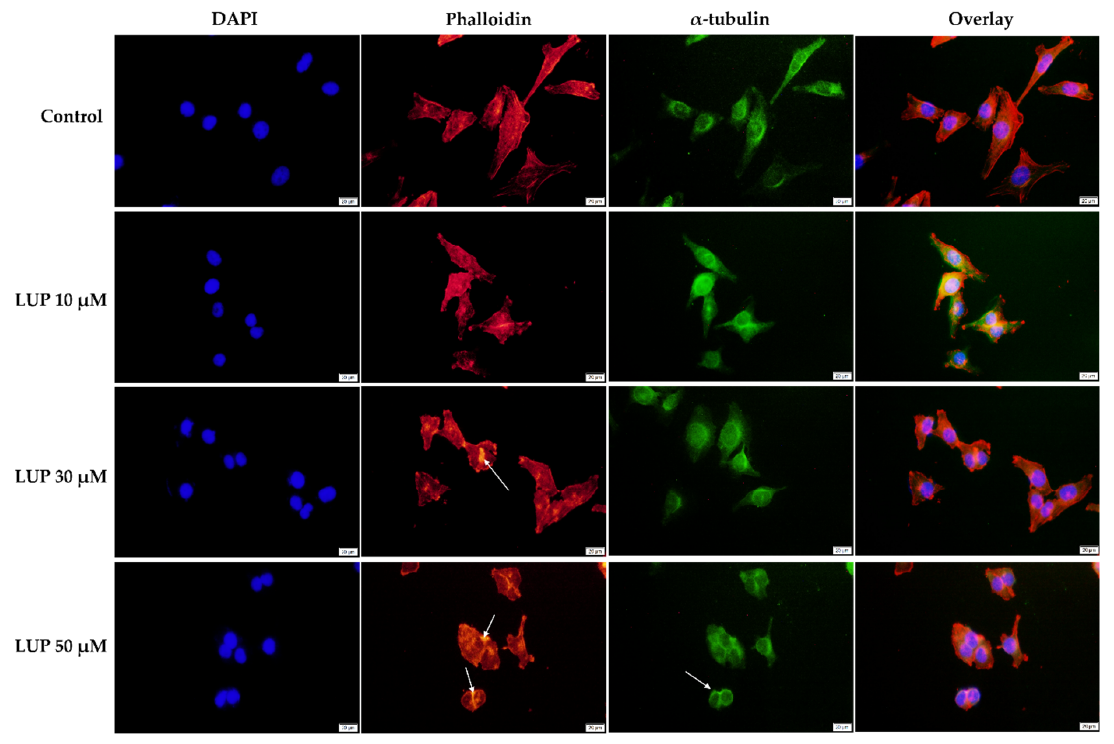
Figure 4. Human melanoma cells ( A375) visualized by fluorescence microscopy following the 24 h treatment with LUP (10, 30, and 50 µM). Cell nuclei (DAPI), actin filaments (phalloidin), and microtubules (α-tubulin) are presented individually and also combined (overlay). The scale bars indicate 20 µm.